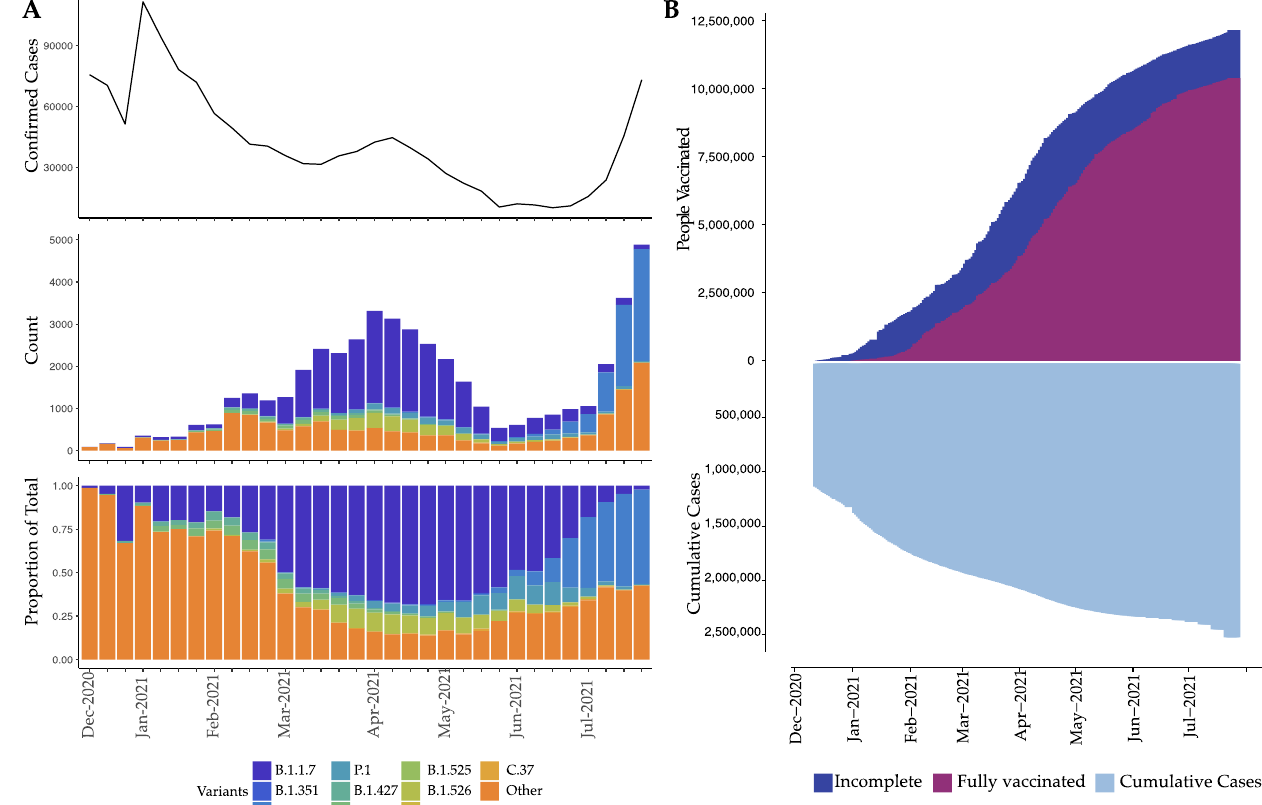
Figure 1. Infection distribution over time in the context of SARS-CoV-2 lineages and vaccination. ( A ) Distribution (y-axes) of previously considered variants of concern (VOCs) over time (x-axis) in terms of number of weekly confirmed cases (top), count of sequenced isolates stratified by VOC (middle), and the proportion of VOC (bottom). Remaining lineages are grouped into “Other”. ( B ) Vaccinated individuals (defined as ”incomplete” for a single dose of Moderna or Pfizer and ”fully” for two doses of Moderna or Pfizer and a single dose of Johnson&Johnson, top) and cumulative number of weekly confirmed cases (bottom) over time (x-axis).